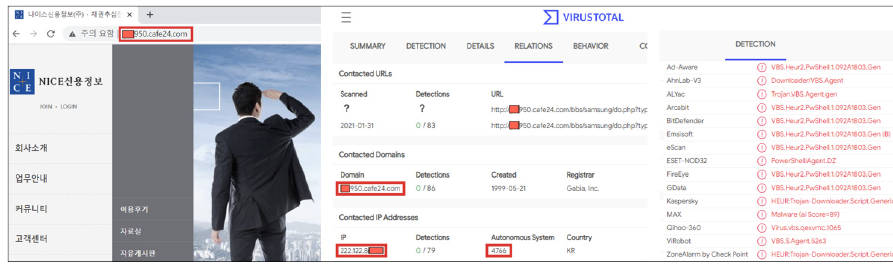
Figure 6. Screen of malicious phishing sites and total virus information.